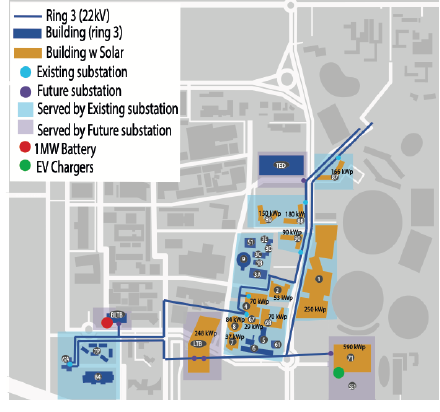
Figure 3. Microgrid